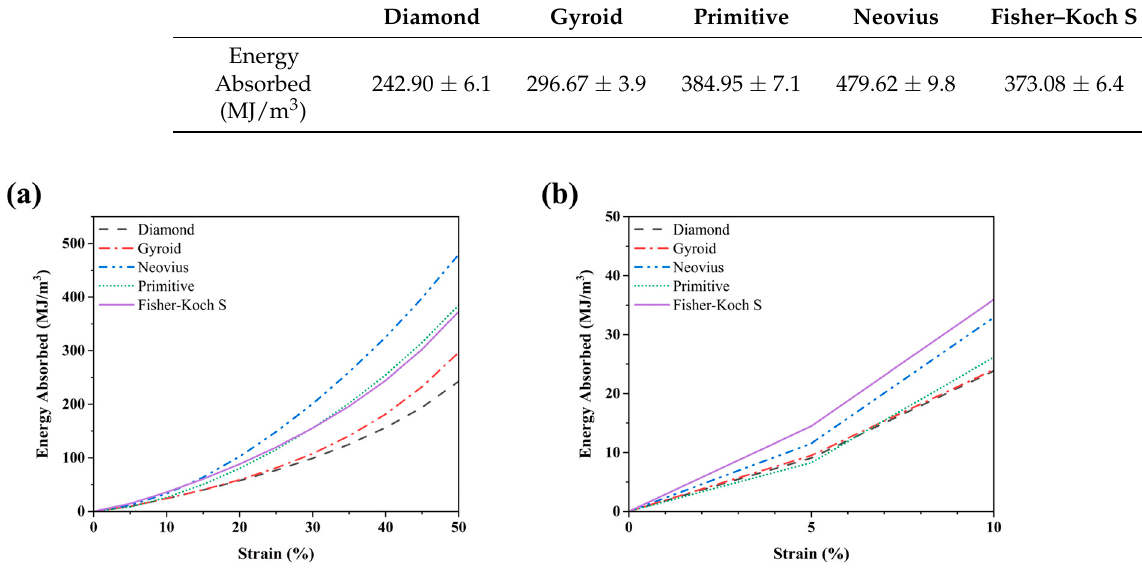
Table 4. Energy absorbed values for different TPMS lattices. Diamond